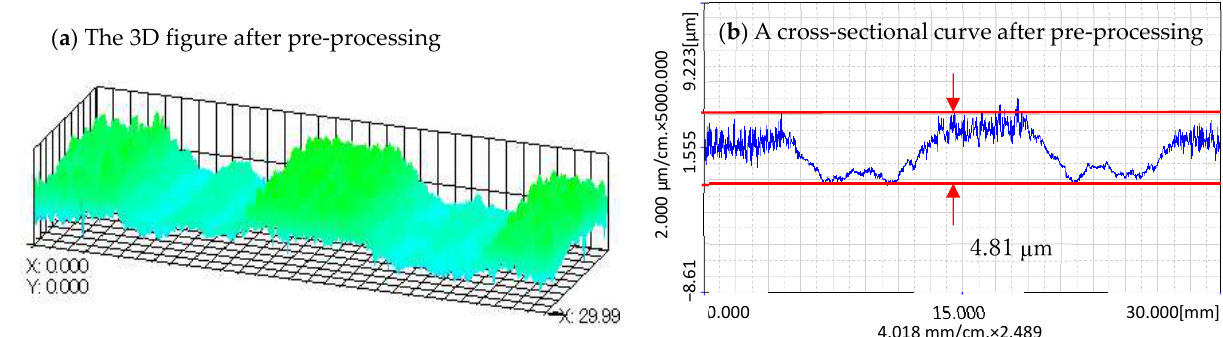
Figure 14. The measurement result of the workpiece surface after pre-processing: ( a ) The 3D figure after pre-processing; ( b ) A cross-sectional curve after pre-processing.